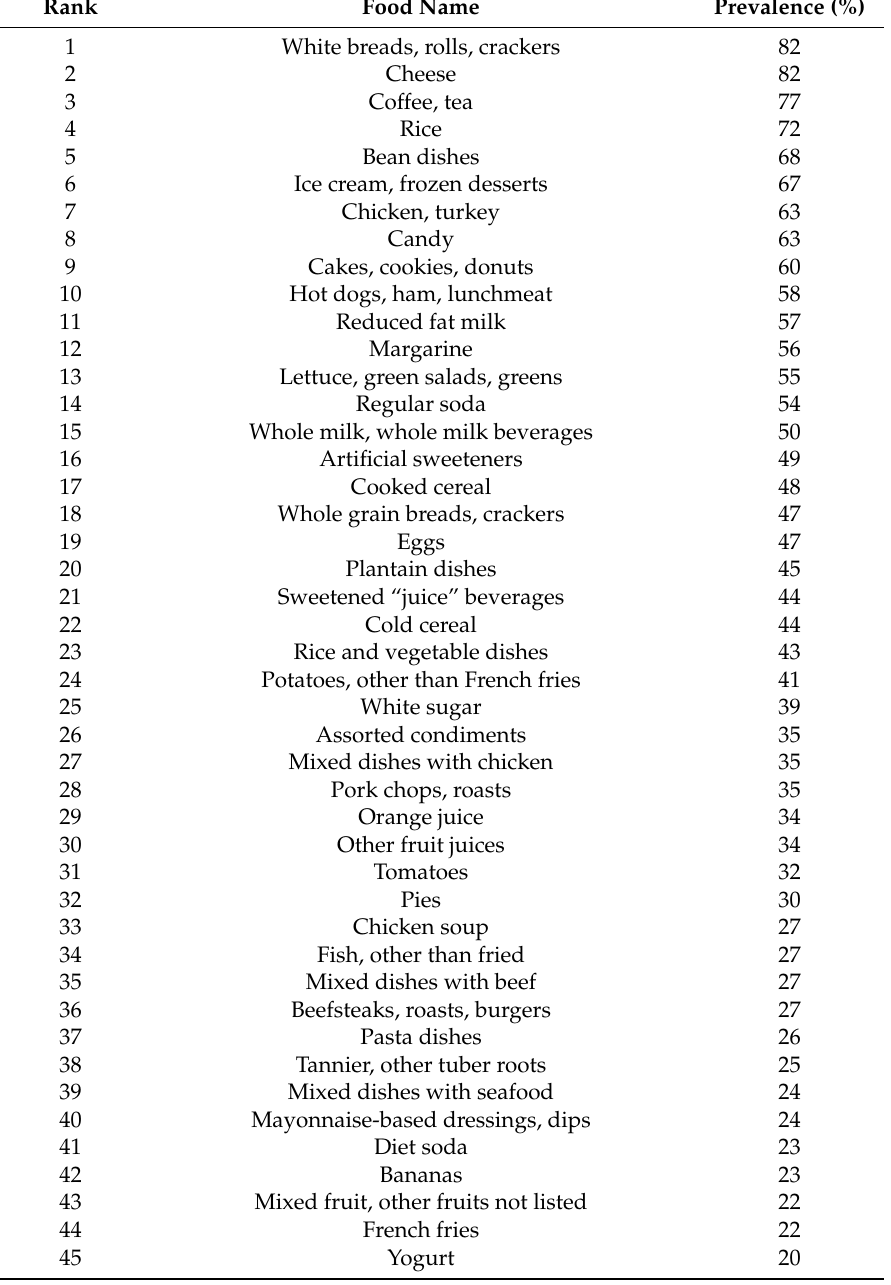
Table 6. Prevalence of Consumption of Foods, Puerto Rican